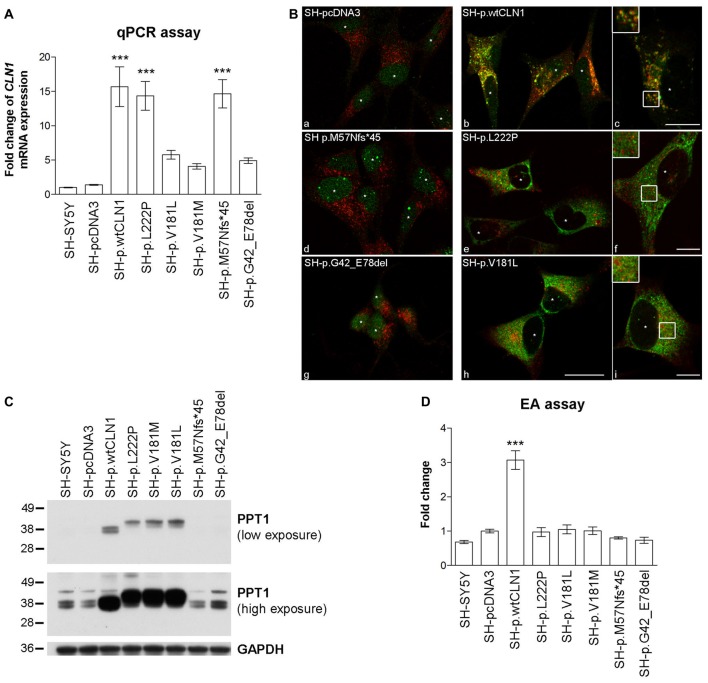
Characterization of CLN1 mRNA and corresponding Palmitoyl-Protein Thioesterase 1 (PPT1) protein expression in CLN1 transfected cells. (A) qRT-PCR quantitation of mRNA expression in transfected CLN1 cells. All transfected cells showed an increased expression of CLN1 mRNA ranging from 5 to 15 fold change in comparison to the endogenous level in controls (both parental and empty vector pcDNA3, mock-transfected cells). Mean ± SEM of three independent experiments; One-way ANOVA followed by Bonferroni’s multiple comparison test; ***p < 0.001. (B) Double immunofluorescence (IF) assay for PPT1 (green) and the lysosomal marker LAMP2 (red) revealed a strong signal of PPT1 in cells which stably expressed either wtCLN1 (b and c) or two different missense mutations (p.L222P, e and f; p.V181L, h and i). Empty vector expressing cells (a), the CLN1 insertion (p.M57Nfs*45, d) and the CLN1 deletion (p.G42_E78del, g) are shown in comparison. A partial localization inside lysosomes was observed for SH-p.wtCLN1 (inset in c), whereas a more diffuse cytoplasmic pattern was detected for SH-p.L222P and SH-p.V181L (f and i). Nuclei are marked by white asterisks; scale bars equal to 20 μm (h) and 10 μm for insets (c, f and i). Colocalization is shown in yellow. (C) Overexpression of PPT1 in both SH-p.wtCLN1 cells and cell lines harboring a missense mutation was confirmed by immunoblotting analysis. The 38–36 kDa doublets were detected in homogenates of wtCLN1 cells. A different pattern was associated with the missense mutation-bearing proteoforms of PPT1- a single band, running approximately at 41 kDa, was detected in homogenates of these CLN1 mutants only. In cells transfected with indel mutations, the 38–36 kDa doublets could be identified following high exposure only, suggestive for a representation of the endogenous PPT1 signal. NT, non-treated; all-trans Retinoic Acid-Neurobasal medium (RA-NBM), differentiated cells. (D) Strong increase in PPT1 enzymatic activity (EA) was observed in SH-p.wtCLN1 as compared to SH-pcDNA3 empty vector cells (3-fold change). Parental SH-SY5Y and cell lines carrying different mutations demonstrated some variability in PPT1 EA, with less than 0.25 fold change in relation to the empty vector transfected cell line. Mean ± SEM of three independent experiments; One-way ANOVA followed by Bonferroni’s multiple comparison test; ***p < 0.001.